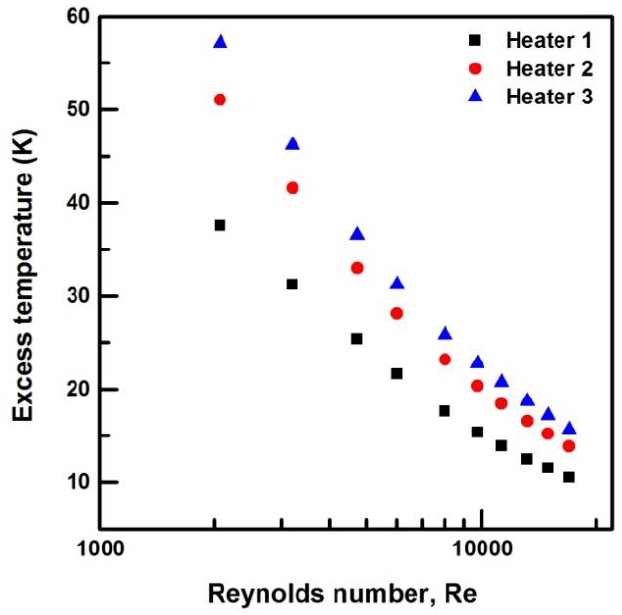
Figure 6. Variation of excess temperature for discrete heat sources